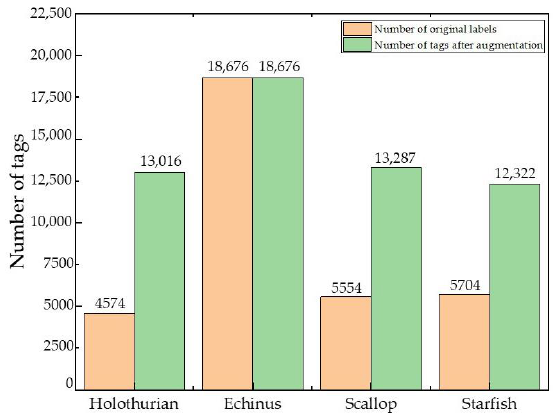
Figure 8. Number of targets after Instance-Balance Augmentation.